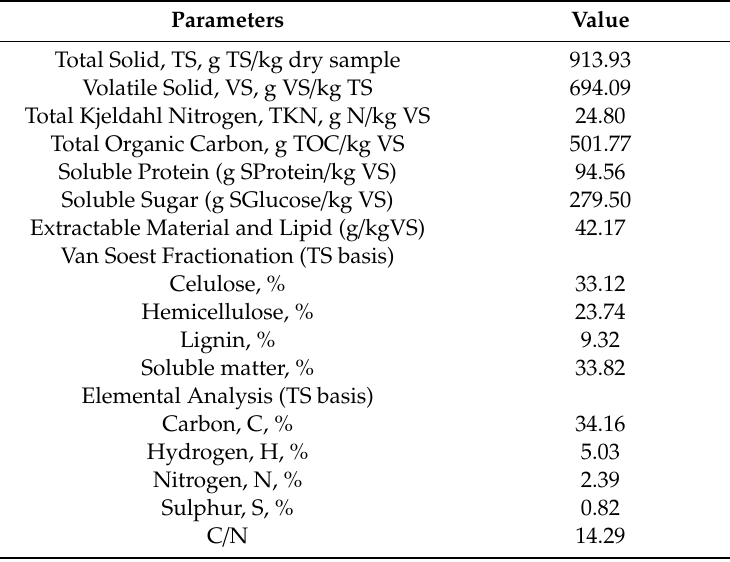
Table 2. Characterization analysis results of